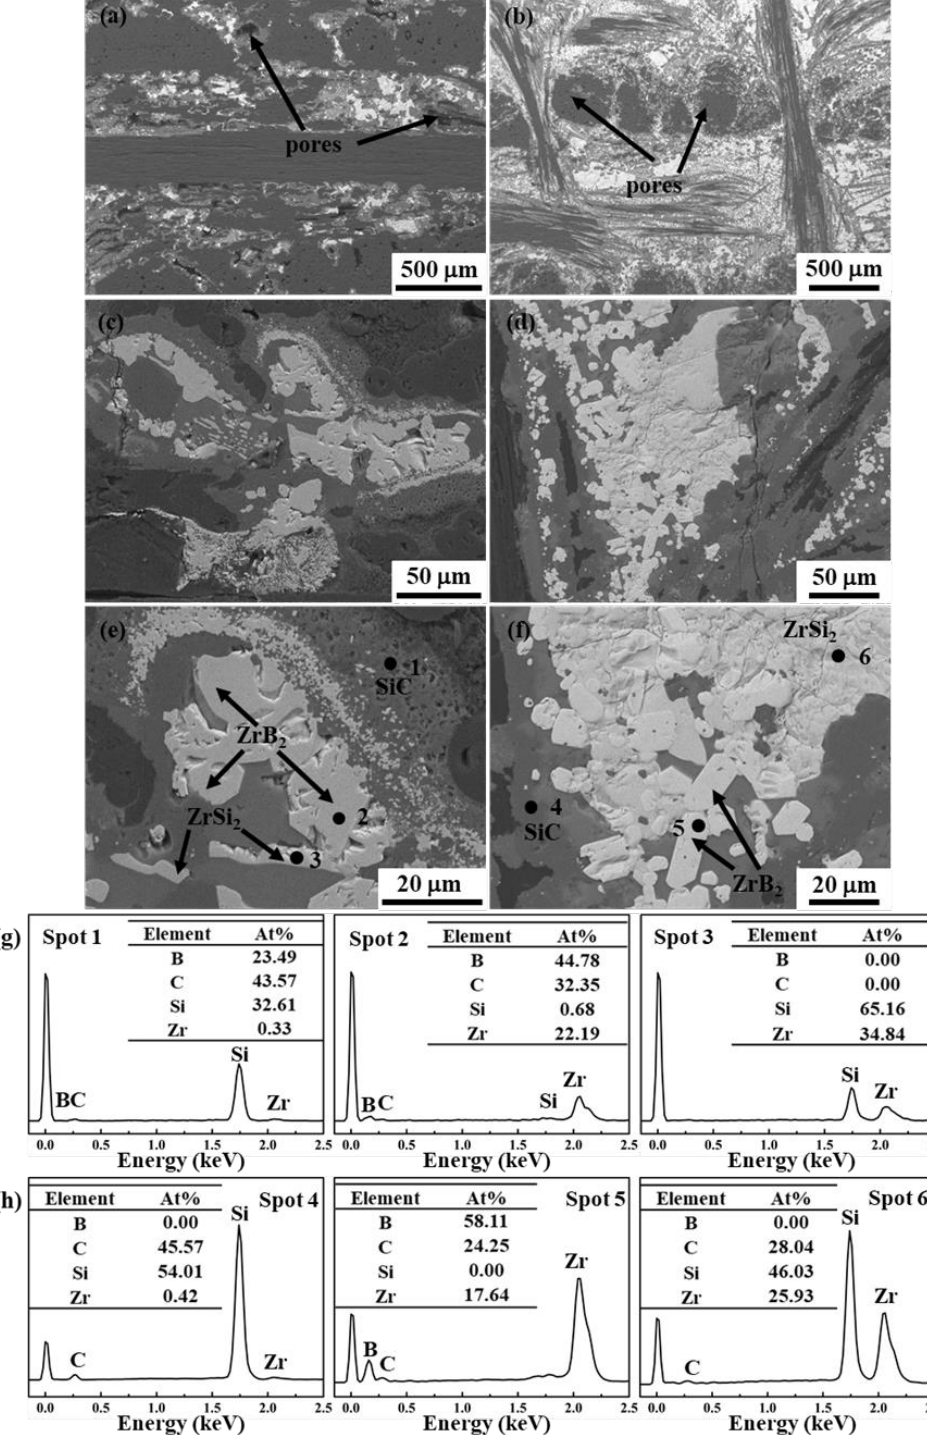
Figure 3. Back-scattering images and EDS analysis for polished cross-sections of C/C–SiC–ZrB 2 composites: ( a , c , e , g ) B 4 C-composite; ( b , d , f , h ) ZrB 2 -composite.